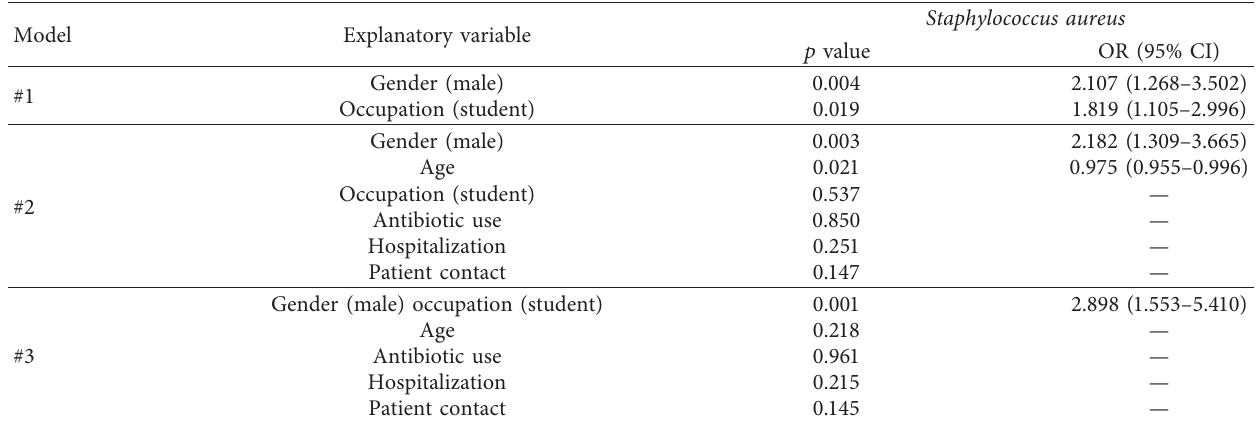
Table 2: Bivariate logistic regression analyses of descriptive variables associated with Staphylococcus aureus nasal carriage among healthcare workers and students attending the University Hospital of Londrina from December 2017 to May 2018.